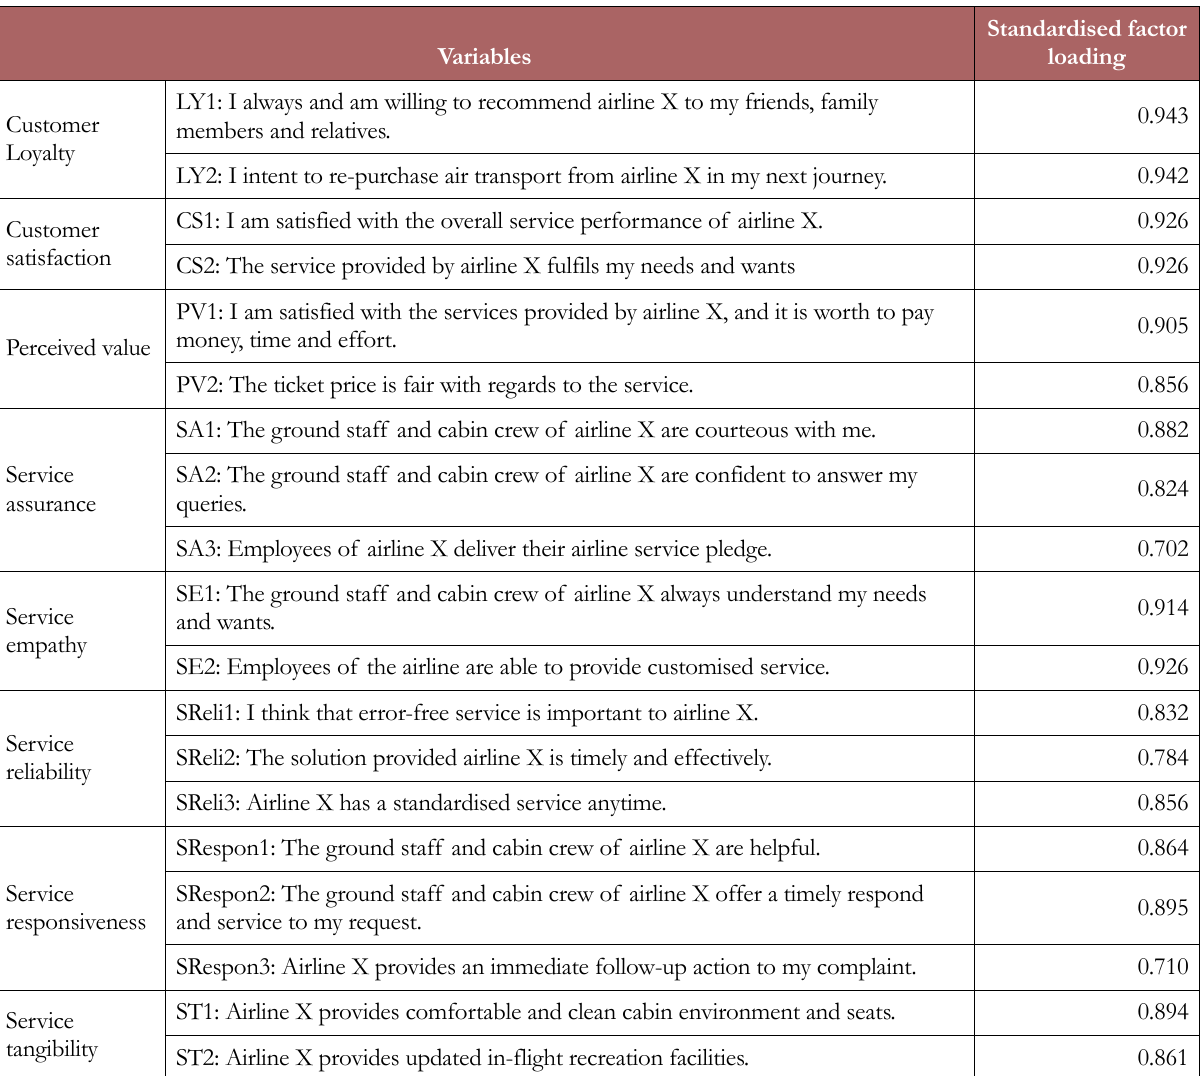
Table 2. Results and measurement of the confirmatory factor analysis